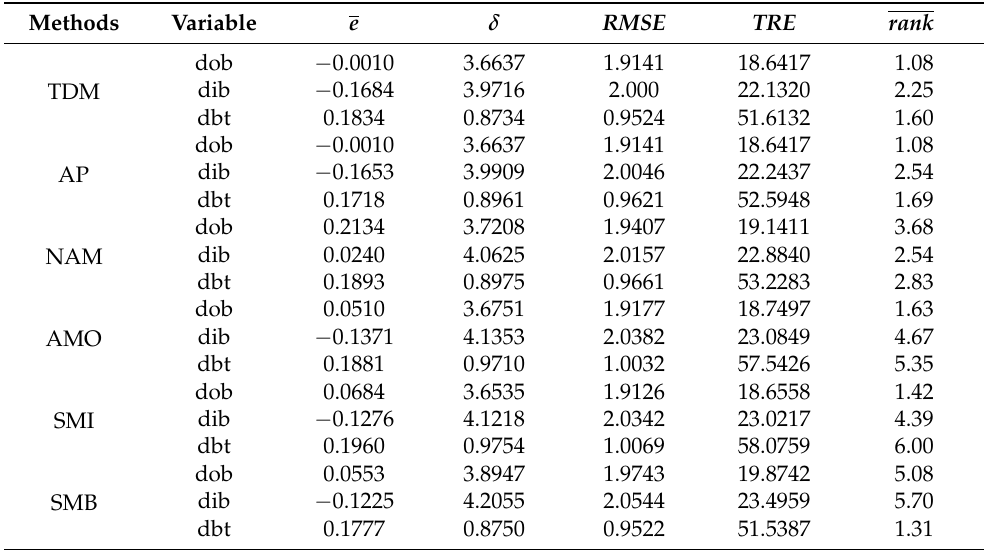
Table 5. Evaluation indices produced from TDM and other compared model structures.